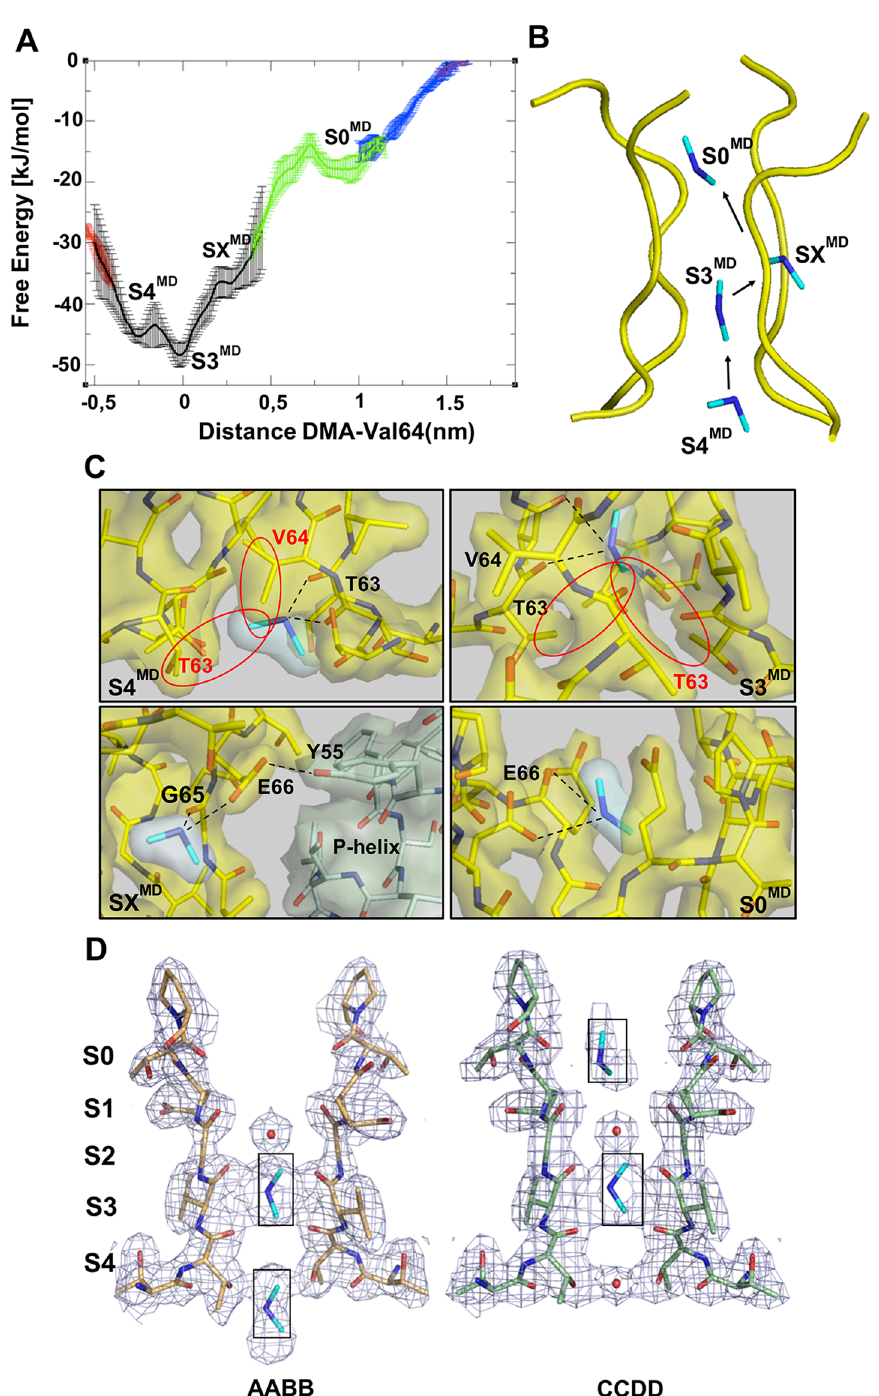
Fig 2. DMA permeation pathway. (A) Free Energy profile (kJ/mol) along the distance of the DMA from its binding site, represented by center of mass of Val64 (nm). The different colors indicate the runs in which the whole BE-META has been divided (See Materials and methods). The different free energy minima are indicated as S4 MD , S3 MD , SX MD and S0 MD . All the free energy profiles are shown with the relative error bars estimated by block analysis [29] (B) Position and interaction of the DMA ions in the different minima along the permeation pathway in the CNG-mimic selectivity filter, as modelled by MD. DMA is depicted in stick, while only the C α trace of the selectivity filter is shown. (C) Close-up of the MD structures corresponding to the minima shown in (A-B). The residues forming hydrogen bonds with DMA (Thr63; Val64; Gly65; Glu66 and Tyr55) and the DMA itself have been drawn as sticks. The